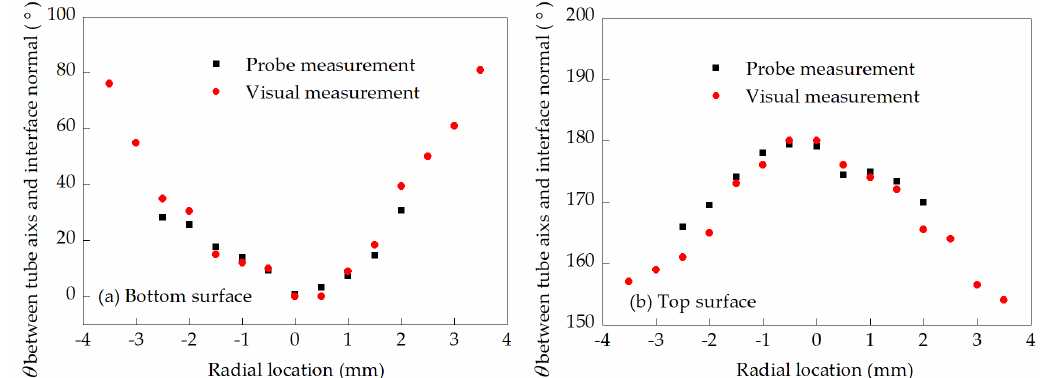
Figure 14. Angle between interface normal and tube axis by probe and visual measurement. ( a ) Bottom surface direction of the bubble; ( b ) Top surface direction of the bubble. Table 2. Mean probe and visual measurement of void fraction, IAC and bubble velocity. Items